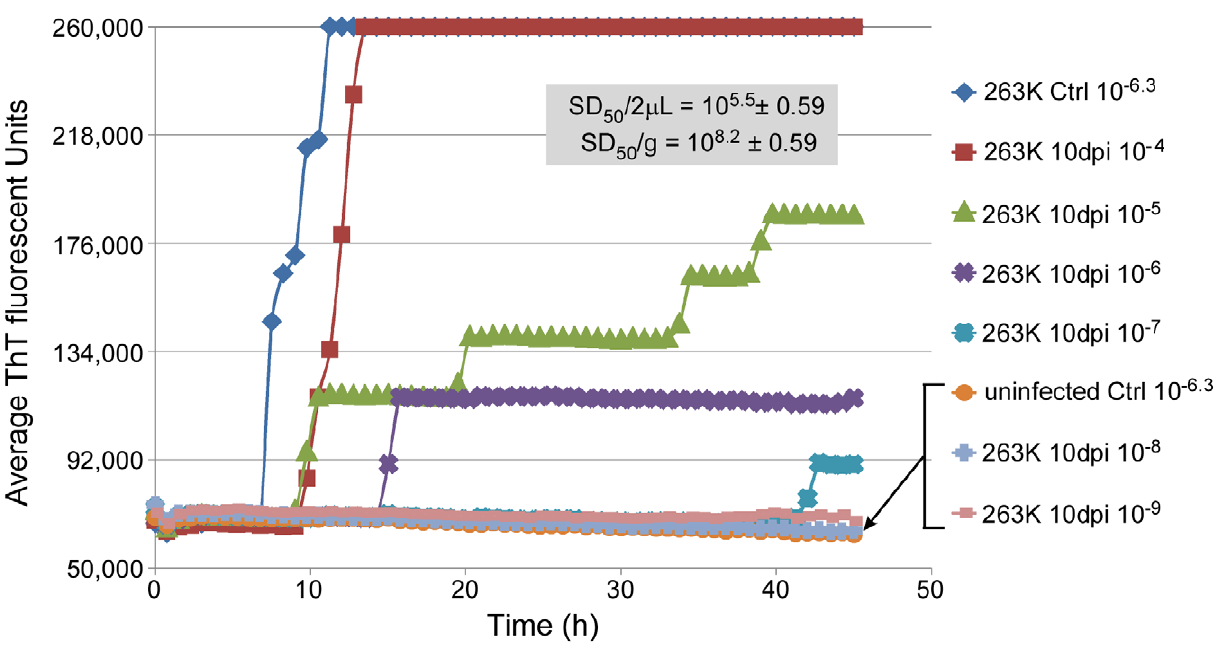
Figure 4. RT-QuIC end-point dilution analysis of three 263K-inoculated preclinical 10 dpi hamster BHs. Hamsters were i.c.-inoculated with 263K scrapie BH. Animals were sacrificed at 10 dpi and brains were analyzed with RT-QuIC dilution analysis. Eight replicate wells were used for each BH dilution. The average Spearman-Ka¨rber estimates of the SD 50 /2 m l and SD 50 /g neat brain tissue from three animals are shown.